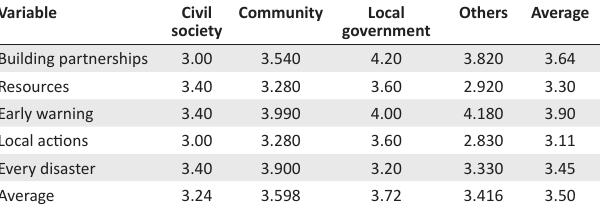
TABLE 4: Participants views on organising and action of risk.